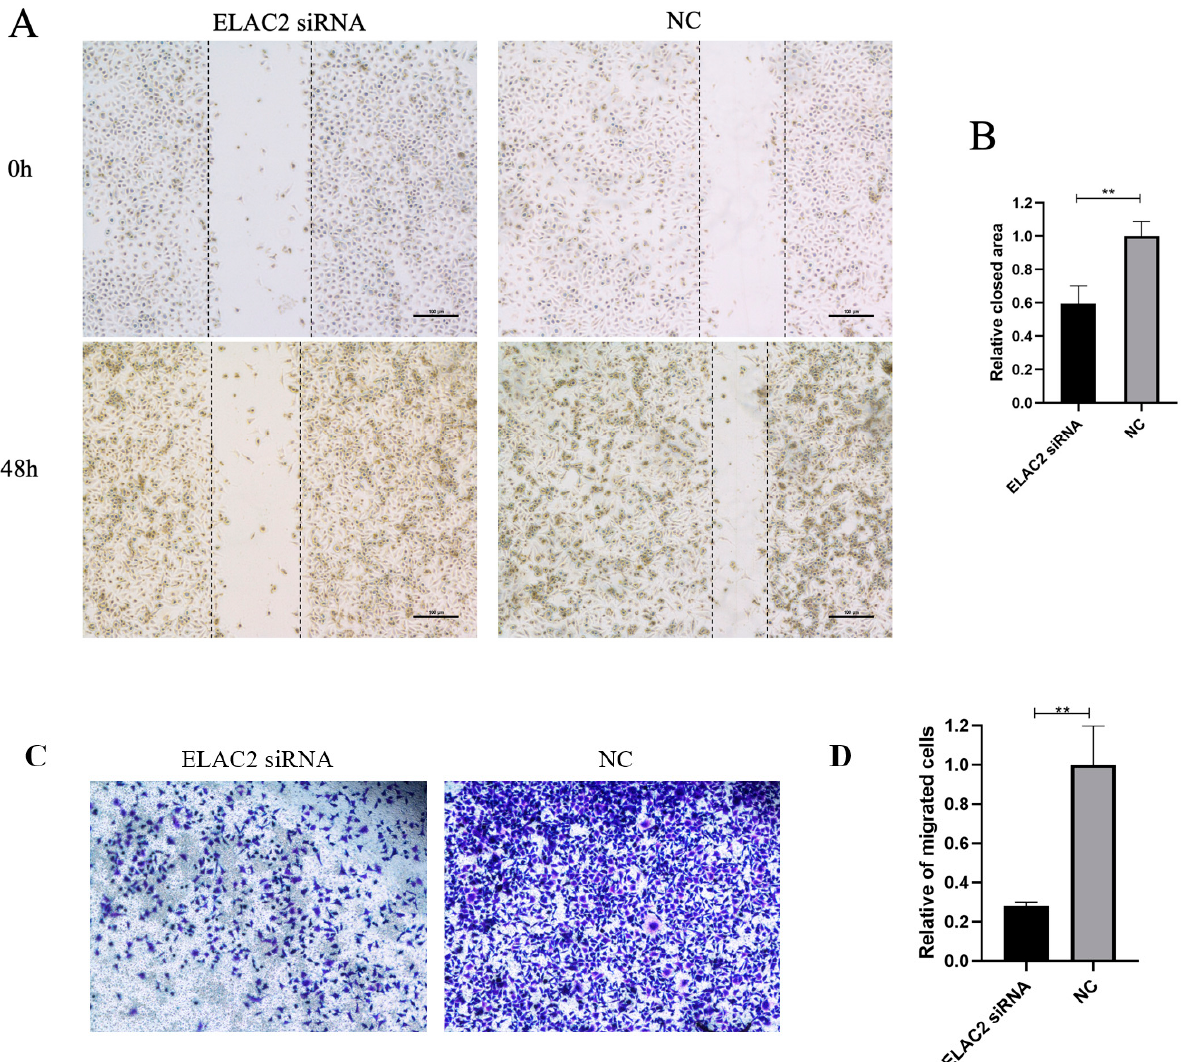
Figure 7. Downregulation of ELAC2 interfere with cell migration in HTR-8/Svneo. ( A ) Representa- tive image of wound healing assay. ( B ) Results of software calculation of relative closed area in cells. ( C ) Representative image of transwell migration assay. ( D ) Results of software calculation of relative migration cells. ** p < 0.01.